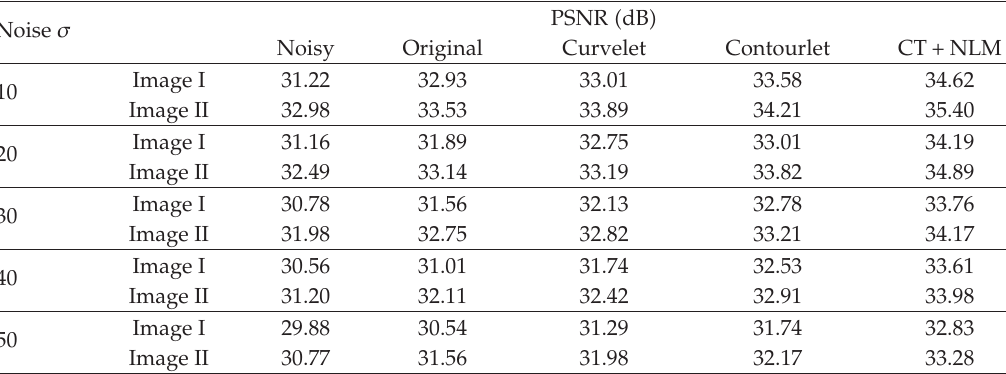
Figure 10: Process results for image IV. Table 1: PSNR